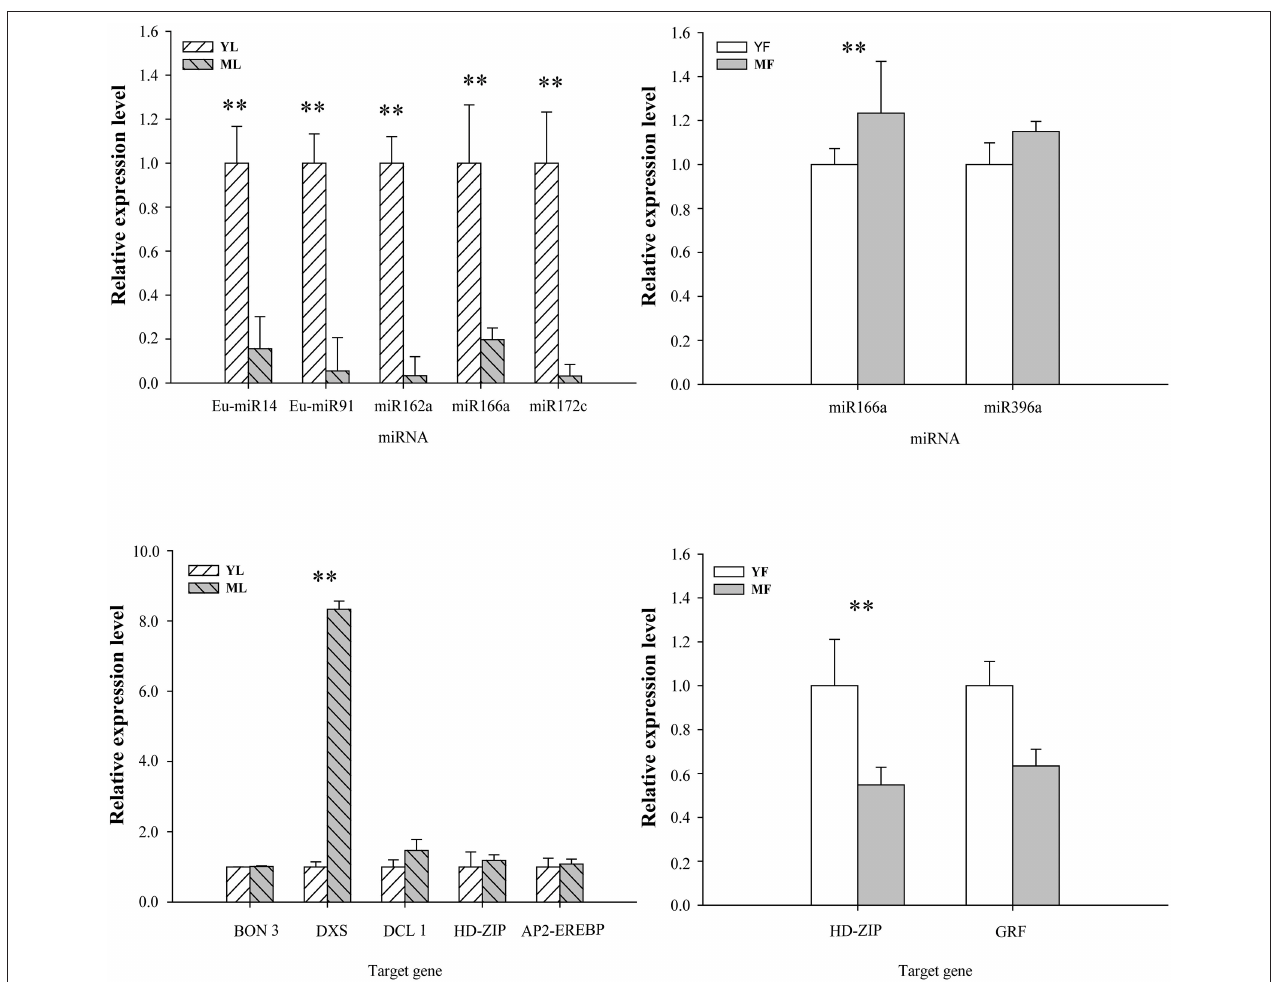
FIGURE 4 | qPCR analysis expression levels of miRNAs and their targets in Eucommia ulmoides. All data were subjected to analysis of variance (ANOVA) and the data represent the mean ± S.D. The results were considered statistically significant at (* p < 0.05) or (** p <